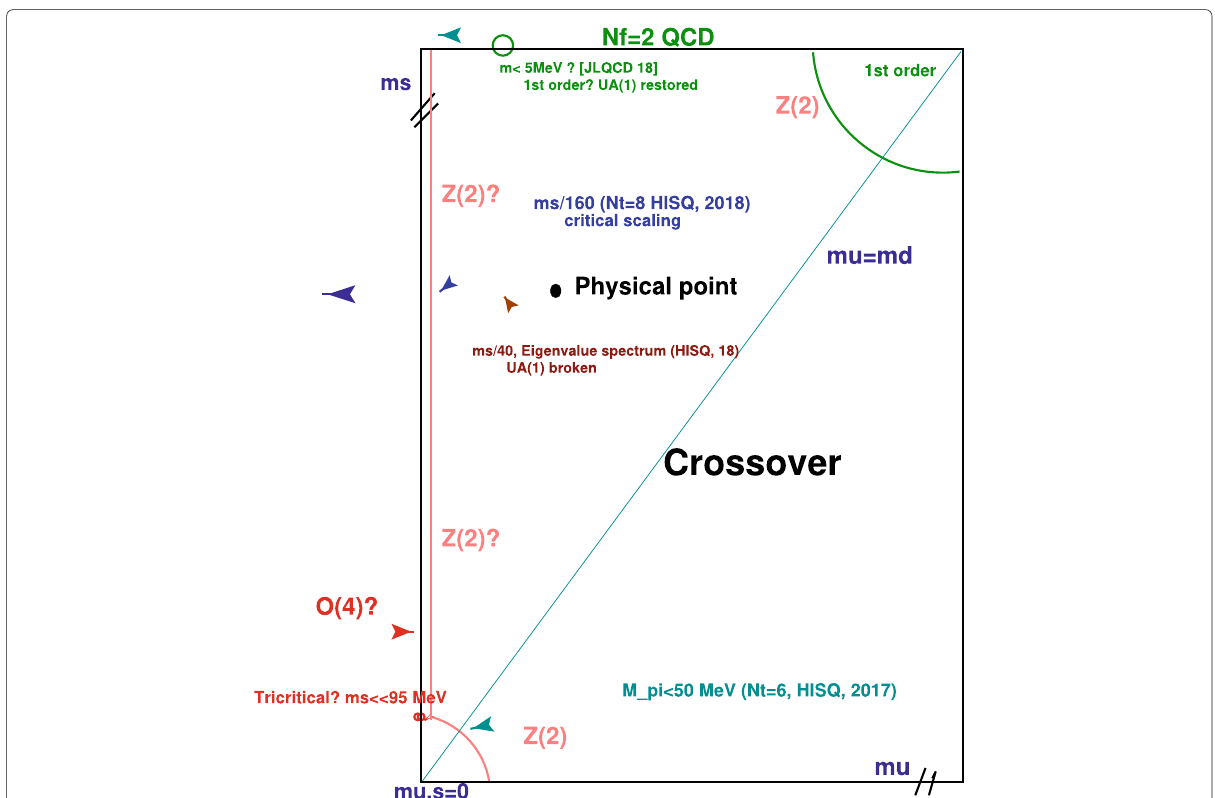
Fig. 1 The current status of Columbia plot from various lattice studies, most recent of which are shown as arrows on the diagram, taken from reference